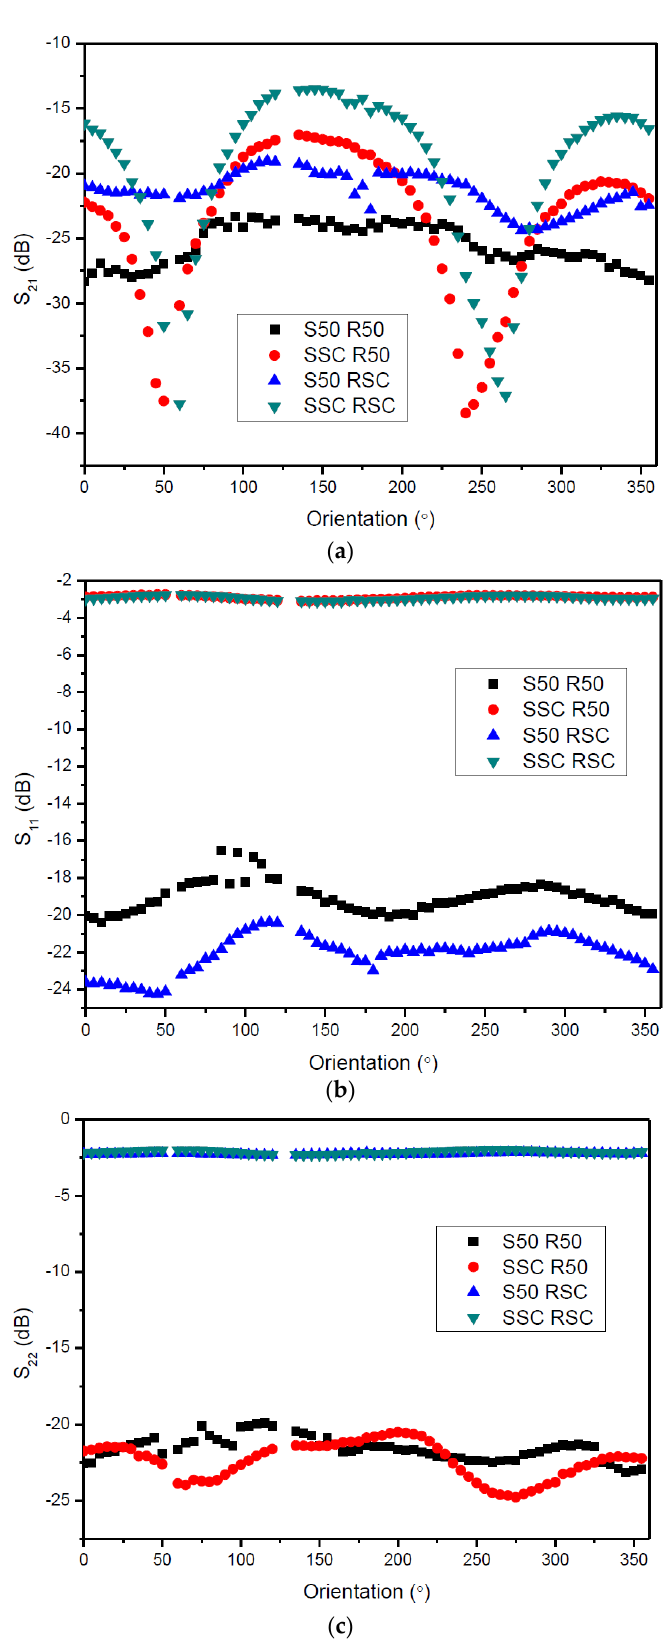
Figure 6. ( a ) S 21 , ( b ) S 11 and ( c ) S 22 measured for different stator/rotor terminations and coupler orientations.